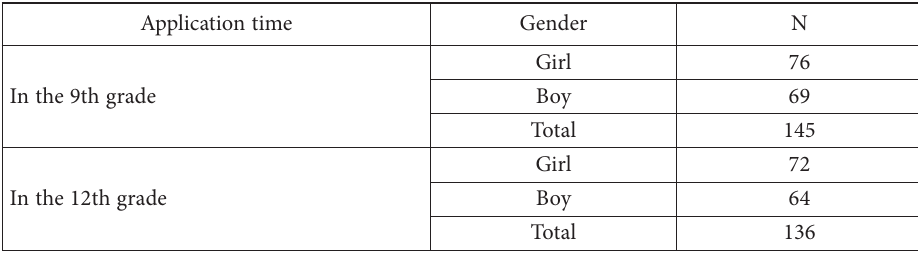
Table 1. Gender-based distribution of the sample by years (source: created by author) Application time Gender N In the 9th grade